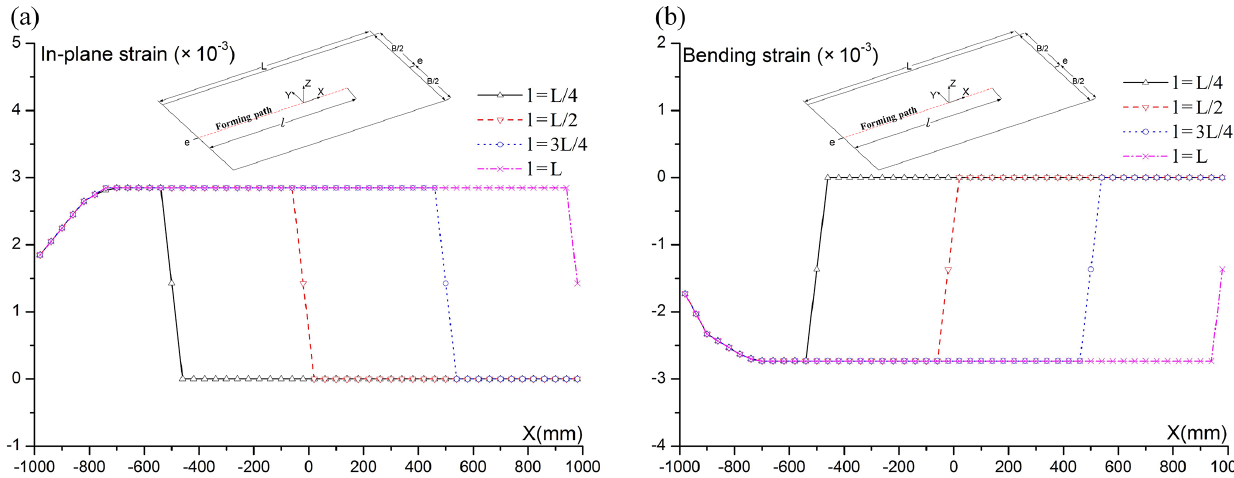
Figure 6. Relationship between length of loading path and midline strain variation of the rolling line of pressed plate. (a) In-plane strain distribution. (b) Bending strain distribution.